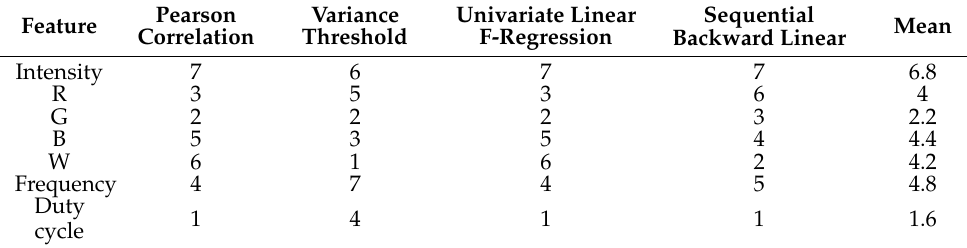
Table 12. Elimination order for the linear model group.